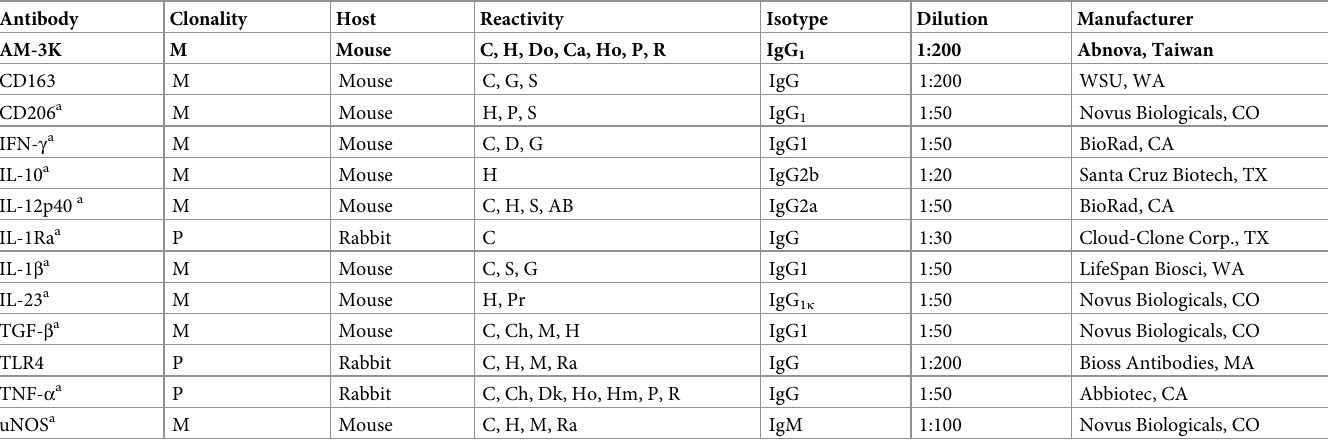
Table 1. Primary antibodies used in study. Antibody